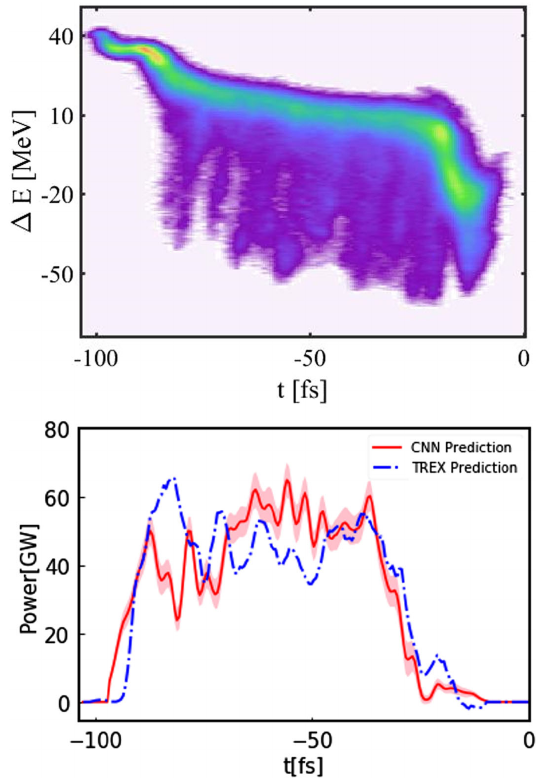
FIG. 6. The experimental XTCAV measurement of a lasing-on phase-space from the SetLong data set, and corresponding predictions from the CNN and TREX